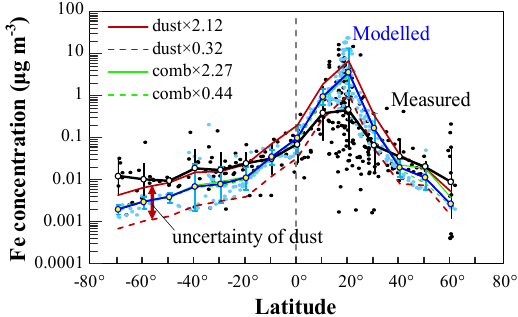
Figure 9. Zonal distribution of modelled (cyan dots) and measured (black dots) Fe concentrations attached to aerosols in surface air over the Atlantic Ocean from 70 ◦ S to 60 ◦ N. The solid lines with circles show the modelled (blue) and measured (black) Fe concen- trations as geometric means in each band with error bars for the geometric standard deviations. As sensitivity tests, Fe concentra- tions from mineral sources were scaled by factors of 0.32 and 2.12 (solid and dashed red lines) as 90% uncertainties in dust emis- sions (Huneeus et al., 2011) and Fe concentrations from combustion sources were scaled by factors of 0.44 and 2.27 (solid and dashed green lines) as 90% uncertainties in Fe emissions from combustion.